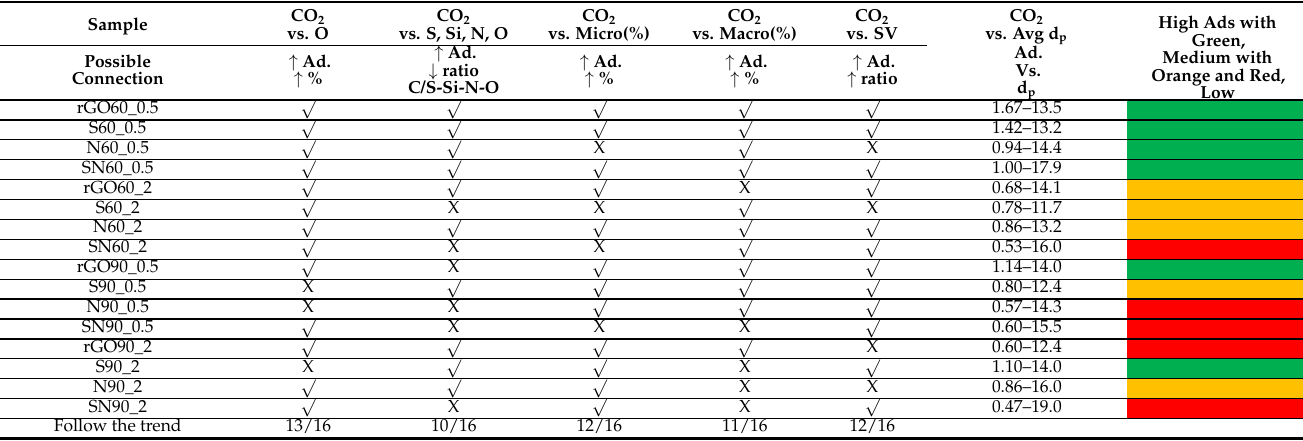
Table 5. Comparison of the CO 2 adsorption with different elemental percentages and porosity values.